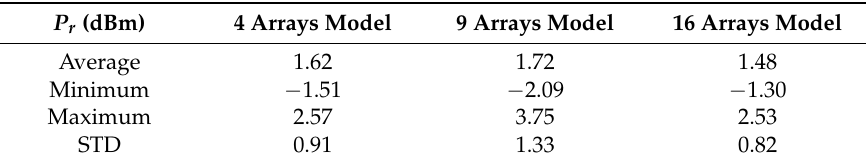
Table 2. Power received for different LED arrangements.